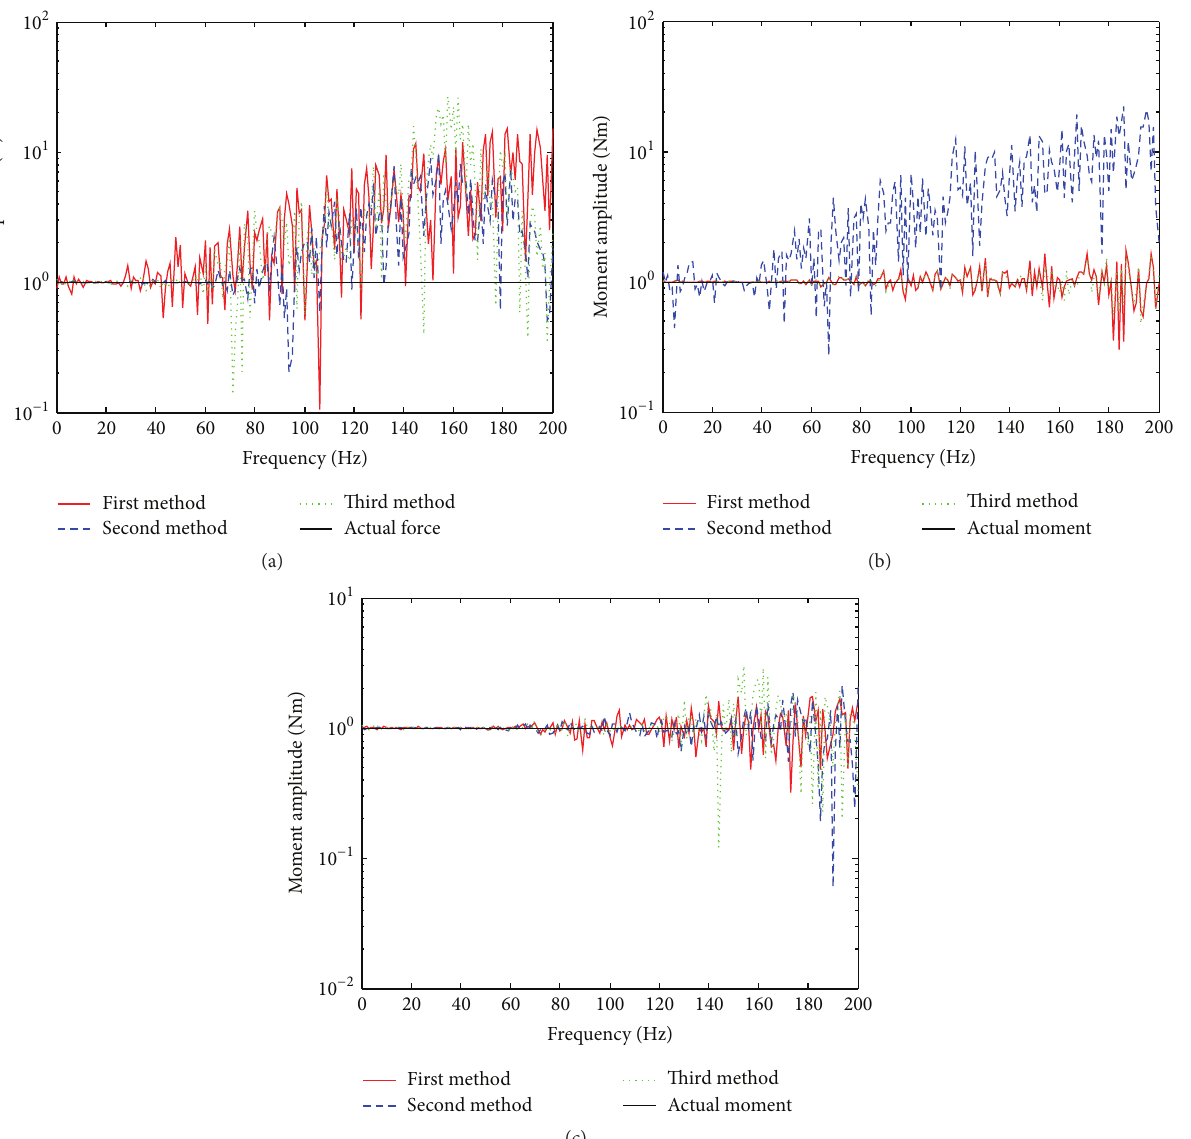
Figure 7: Comparison of estimated inputs by three different methods and actual inputs. (a) Force in 𝑧 -direction. (b) Moment around 𝑥 - direction. (c) Moment around 𝑦